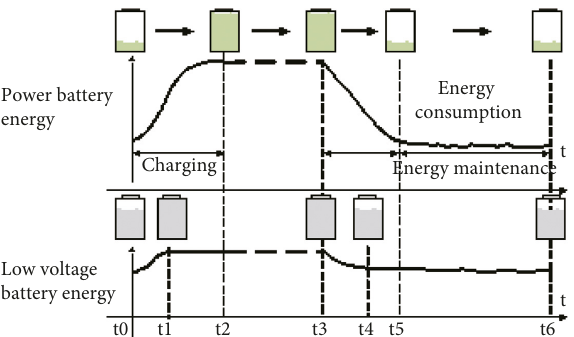
Figure 5: Energy management process.